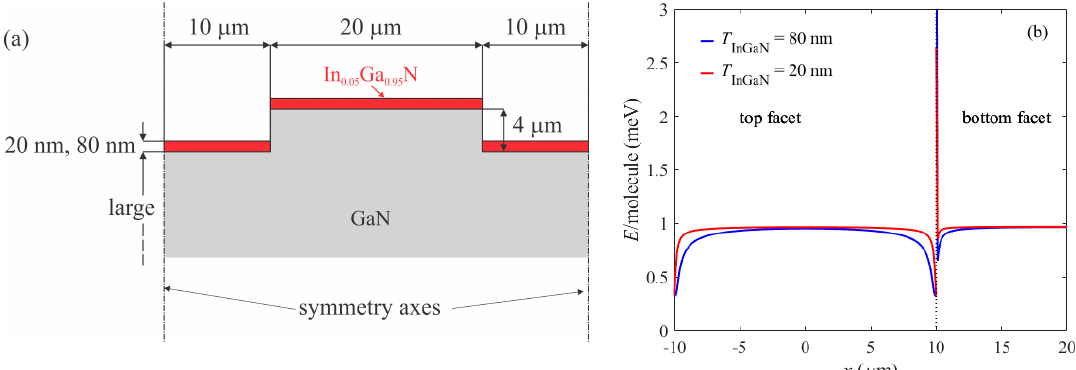
Figure 9. ( a ) Structure model used for the calculation of elastic energy. ( b ) Lateral profiles of the elastic energy per one InGaN molecule at the top and bottom InGaN surfaces.